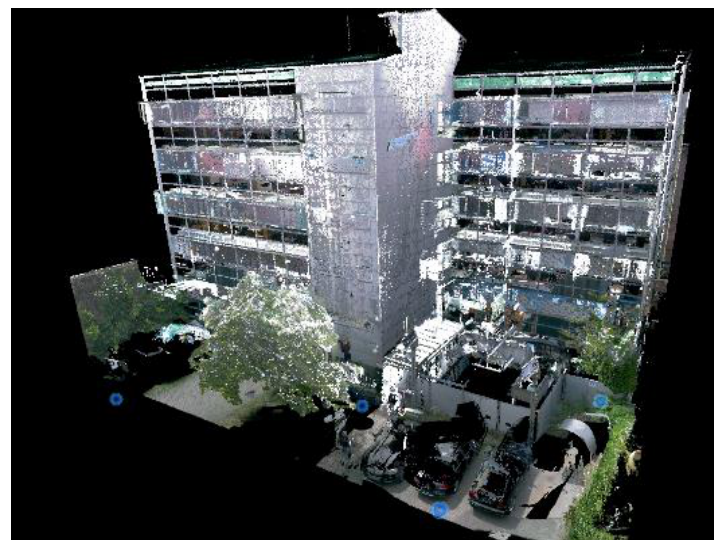
Figure 7. Laser scanning workflow. Buildings 2022 , 12 , x FOR PEER REVIEW